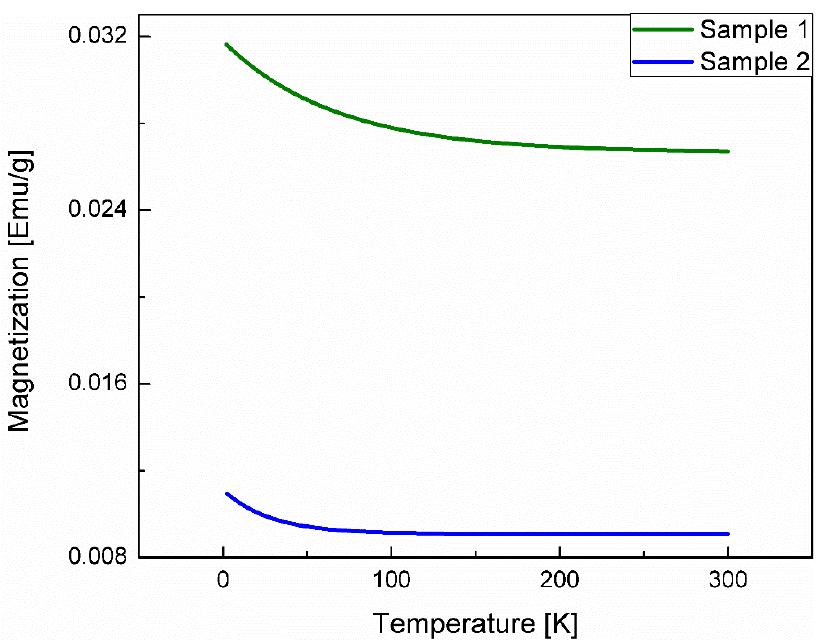
Figure 7. Temperature-dependent magnetization at 0.1 T from 2 to 300 K for sample 1 (green) and sample 2 (blue). Neither sample shows any sharp phase transition above 2 K. Similar to the B – H curves, sample 1 has greater magnetization than sample 2.